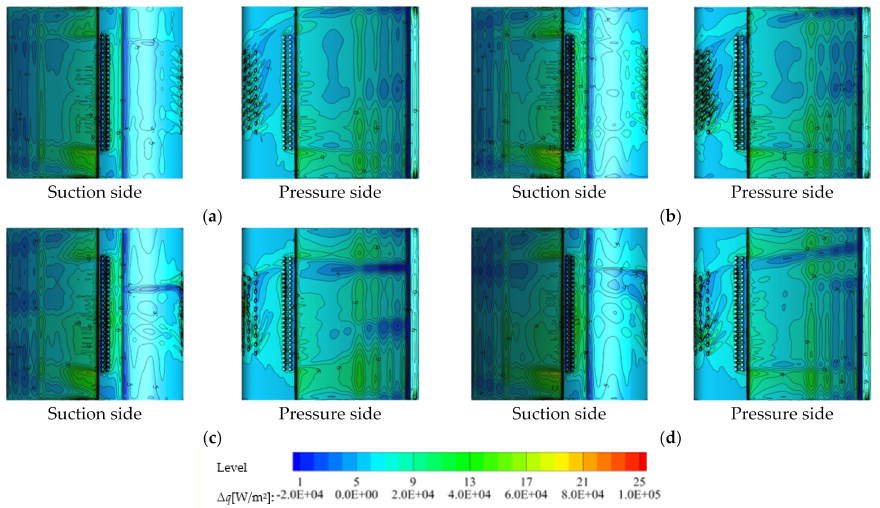
Figure 15. Local heat flux drop distribution for different cases. ( a ) Case 1: uniform inlet; ( b ) Case 2: HS only; ( c ) Case 3: HS and positive swirl; ( d ) Case 4: HS and negative